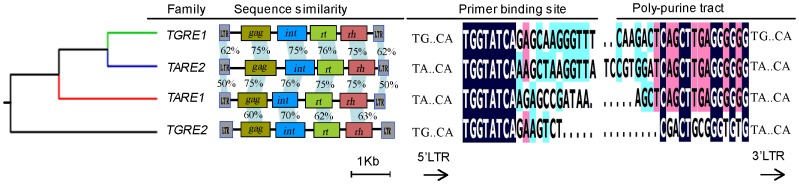
Phylogenetical relationship and sequence similarity between TGRE1, TARE2, and TARE1.The phylogenetically closest family TGRE2 was set as an outgroup. The physical positions of each representative element are located at chromosome 1 from 27235875 to 27240535 for TARE1, chromosome 7 from 61990209 to 61994987 for TARE2, chromosome 5 from 23621836 to 23626419 for TGRE1, and chromosome 11 from 7616310 to 7621220 for TGRE2, respectively.